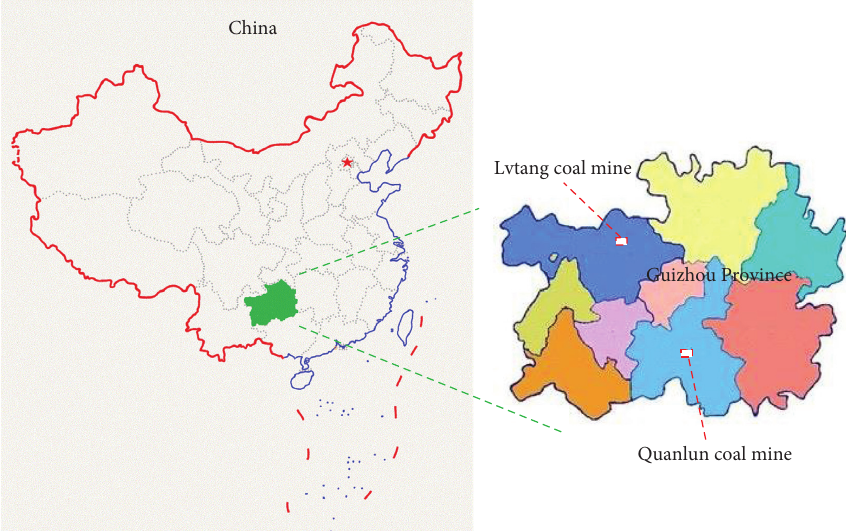
Figure 2: Geographical location of the LT and QL coal